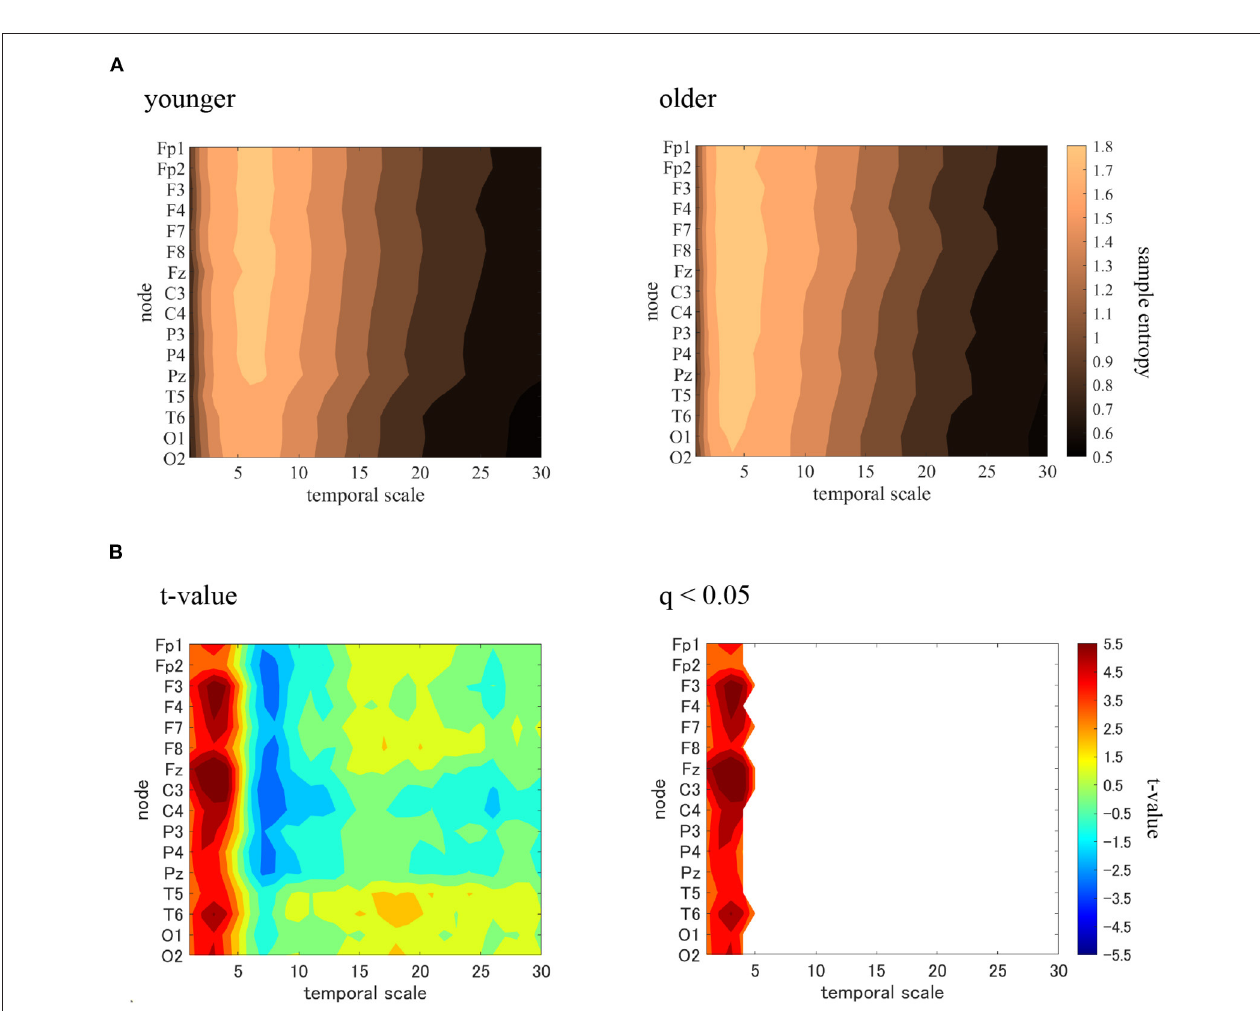
FIGURE 4 | Multi-scale entropy analysis in younger and older groups. The horizontal axis represents the temporal-scale factor, τ . (A) Mean values of sample entropy from 1 (0.005 s) to 30 (0.15 s) scale factors in younger (left part) and older (right part) participants are shown here. (B) t -values comparing the older and younger groups are shown here as well (left part). Warm (cold) colors represents a higher (smaller) sample entropy value for older individuals than for younger participants. The observed t -value satisfies the FDR correction criterion q < 0.050 (right part). A statistically significantly higher sample entropy of the low temporal-scale regions 1 to 5 (0.005–0.025 s) is depicted